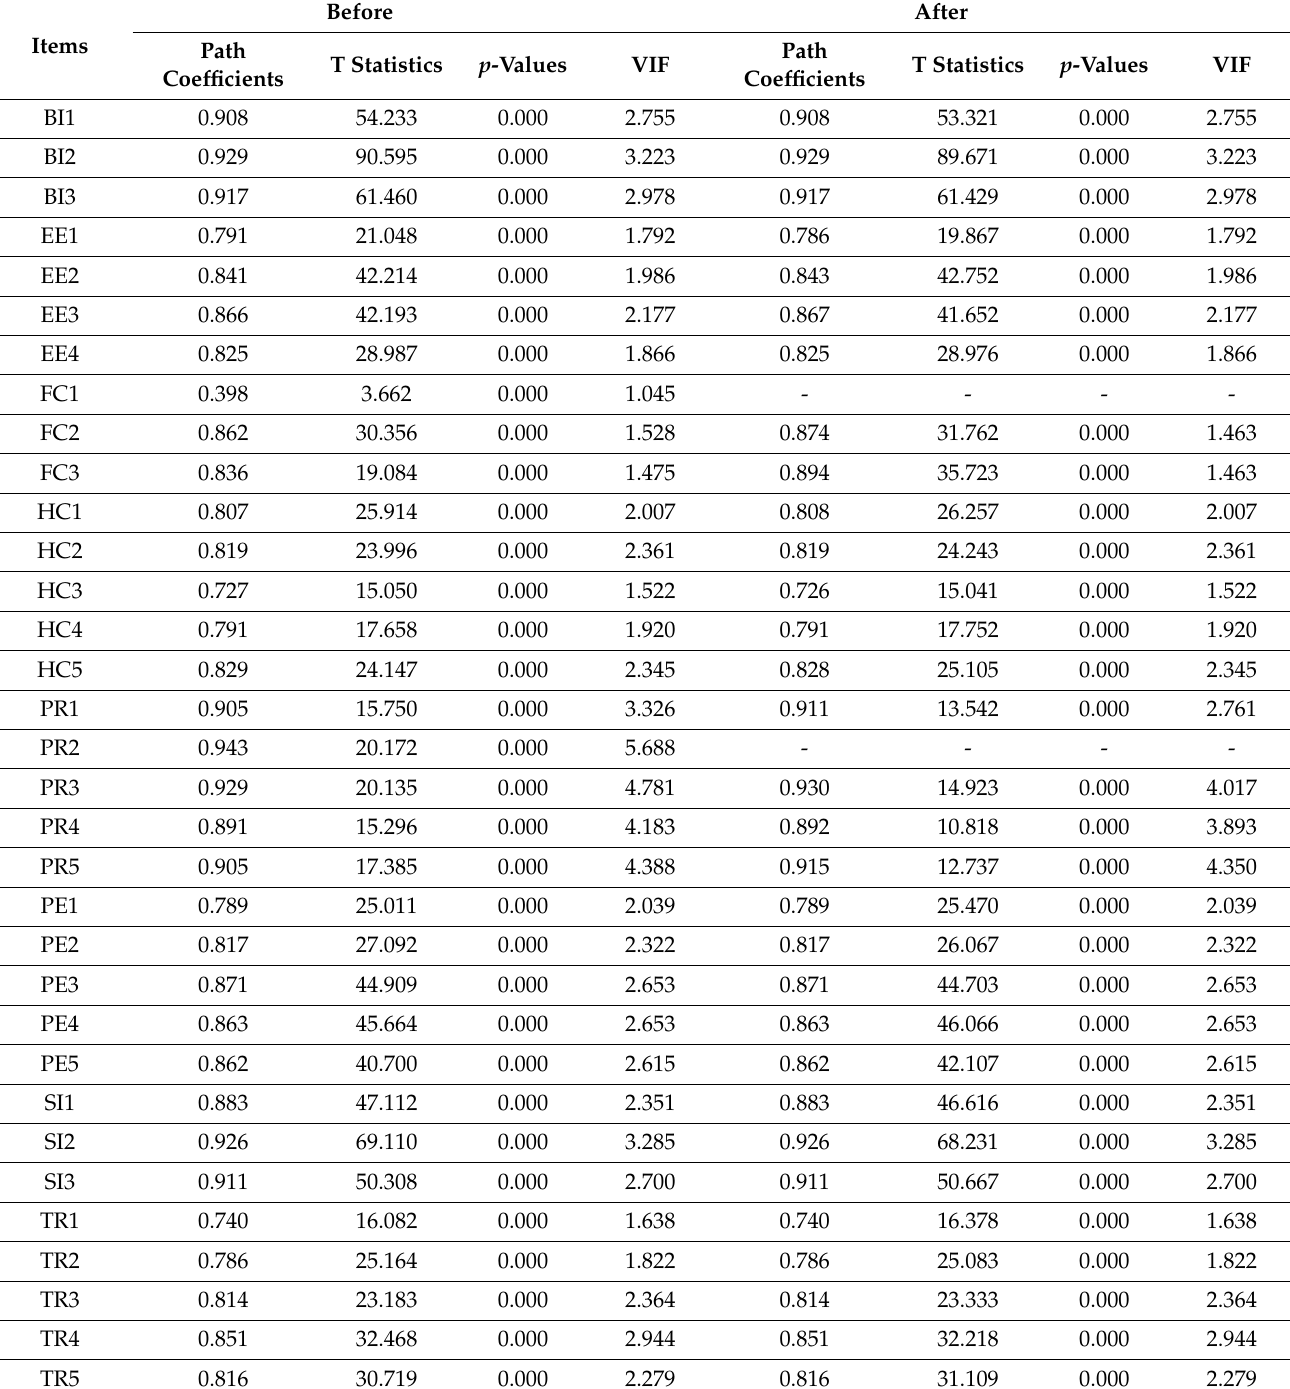
Table 2. Outer loading and VIF test of questionnaire